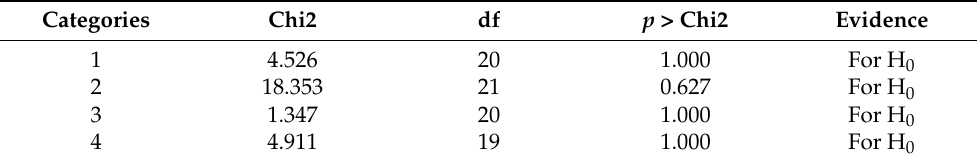
Table A1. The results of IIA